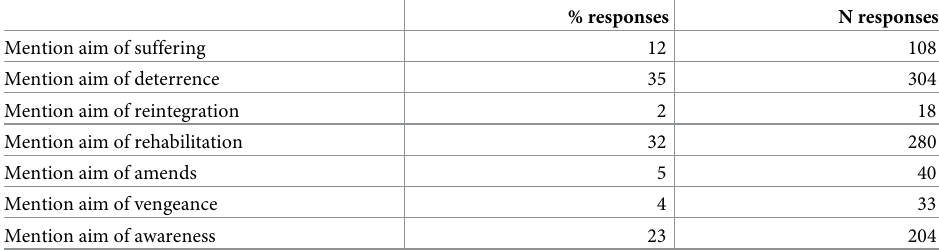
Table 1. Share of open-ended answers that mention particular aims.